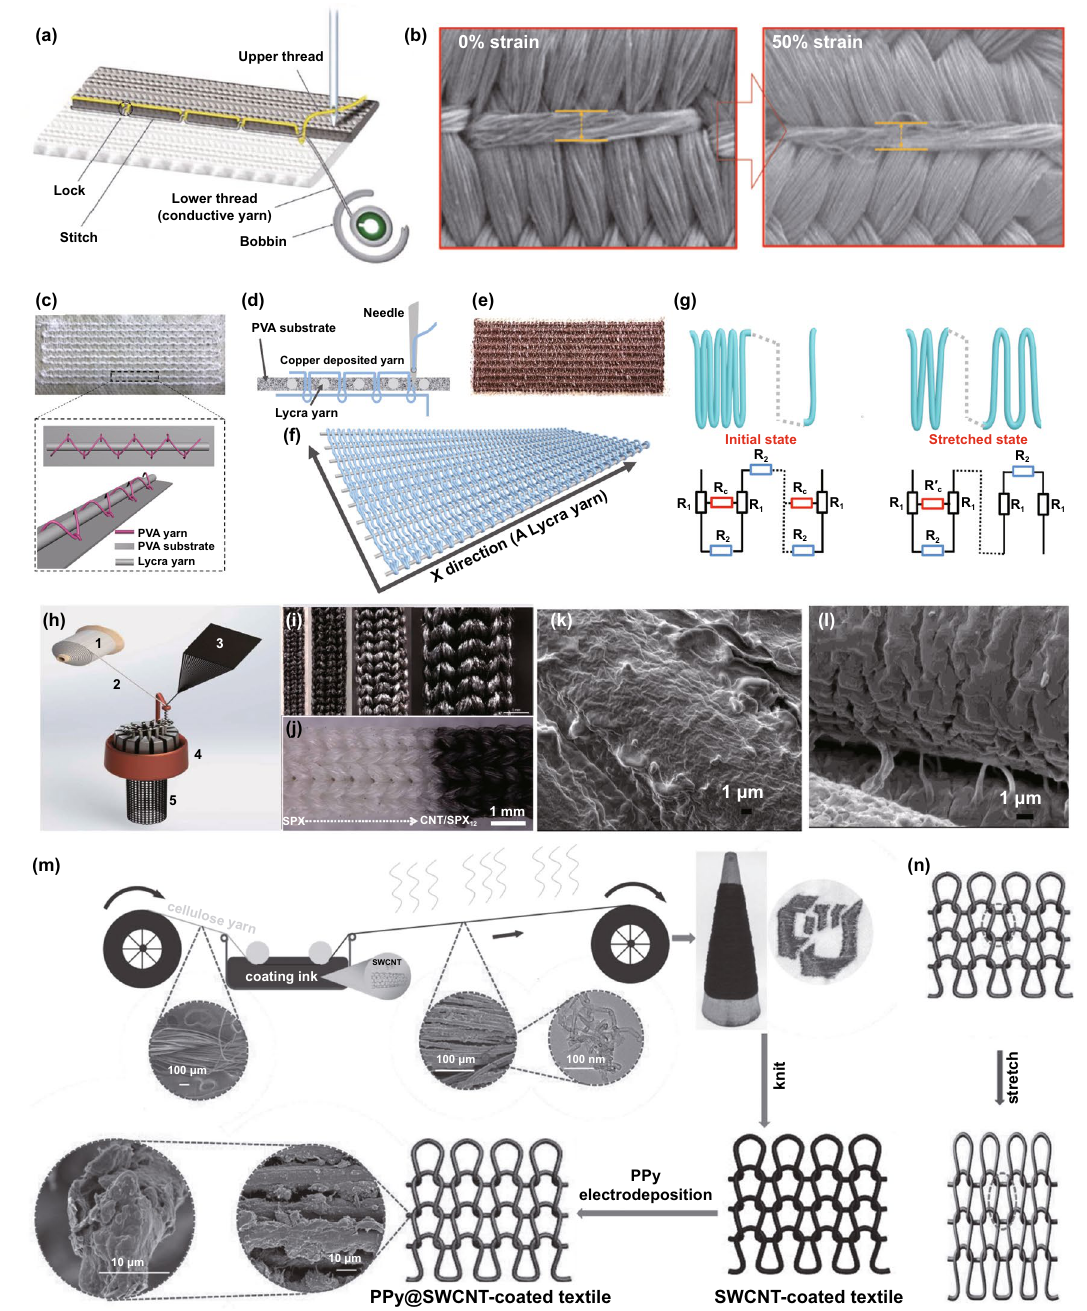
Fig. 8 a Illustration of locking conductive yarns over a textile substrate to fabricate strain sensors, and b the surface morphologies of the strain sensor under 0 and 50% strain respectively [180]. Copyright © 2019 Wiley–VCH. c A rectangular Lycra track fixed onto PVAT substrate by PVAT yarn, and d the diagram of embroidering copper deposited yarn in the Lycra track via lock-stitch embroidery to fabric strain sensors. e The photo of the embroidery pattern with copper deposited yarn and the Lycra track. f The embroidering sensor after dissolving PVAT substrate. g The sensing networks and resistance models of the embroidery sensor under initial and stretched states respectively [6]. Copyright © 2021 Wiley–VCH. h Illustration of fabricating a knitted Spandex/CNT strain sensor through a circular knitting machine, i, j different-structure Span- dex/CNT sensors showing the pattern flexibility of the technique, k the surface CNT on the pristine Spandex fibers, and l the CNT cracks on the stretched Spandex fibers to showing the sensing mechanism [188]. Copyright © 2016 American Chemical Society. m The process of producing a knitting strain sensor through coating CNT and PPy on cellulosic yarns, and n the schematic diagrams of the sensor without and with elonga- tion, showing the mechanism of the sensor can be attributed to geometry effects [189]. Copyright © 2016